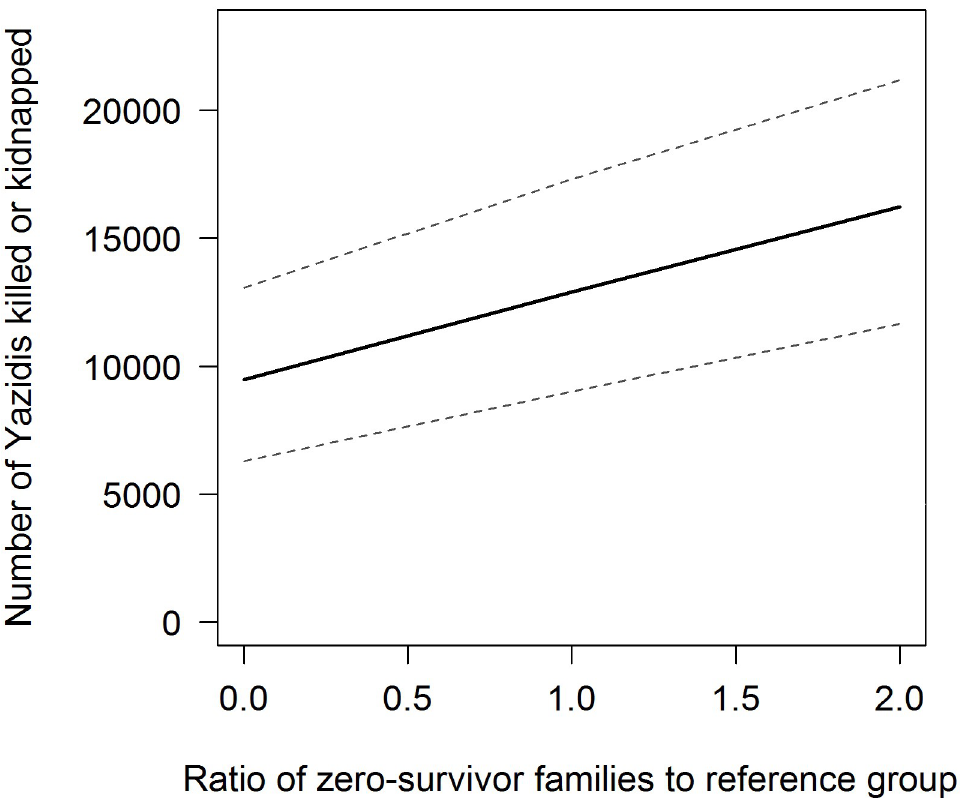
Fig 3. Sensitivity analysis to number of zero-survivor families with 95% CIs. Note: reference group = nuclearfamilies captured in their entirety in which at least one member escaped.